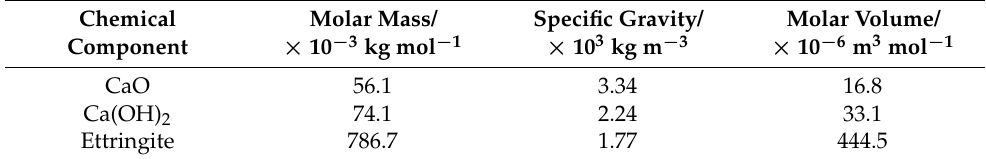
Table 1. Molar volume